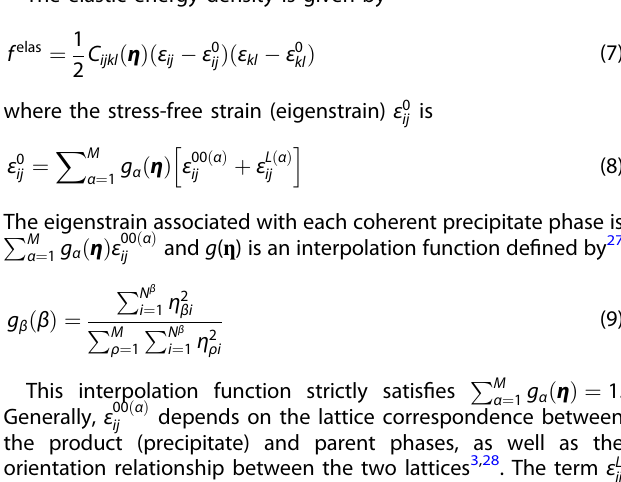
(cid:2) E el > γ (cid:2) γ − ∂ E el / ∂ ξ < ∂ γ / ∂ ξ (CL will spontaneously coh and coh